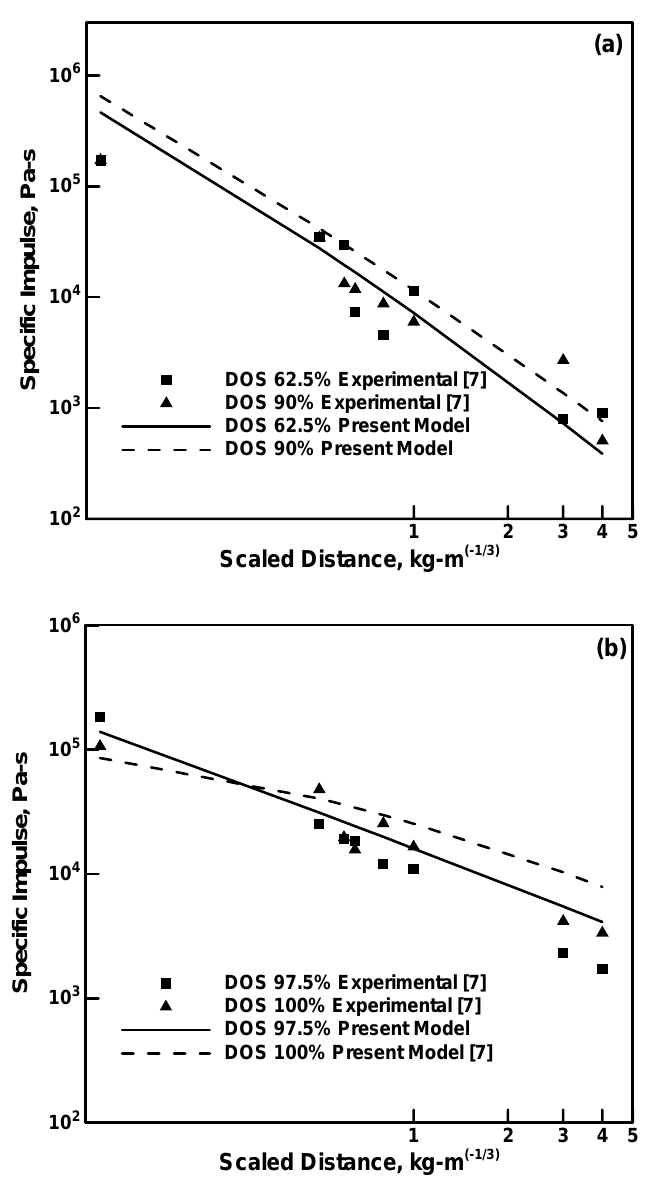
Fig. 8. Variation of specific impulse with the scaled distance from the charge center and the degree of saturation. Explosive weight and type: 8 kg TNT; Sand type: Sandy loam. (c) For the cases of 0 cm and 3 cm DOB, the central portion of the crater appears to be nearly flat, Fig. 9(a)–(b), while for the case of 8 cm DOB, Fig. 9(c), the central portion of the crater contains a minor bulge. The corresponding computational results obtained using the original compaction model for sand are displayed